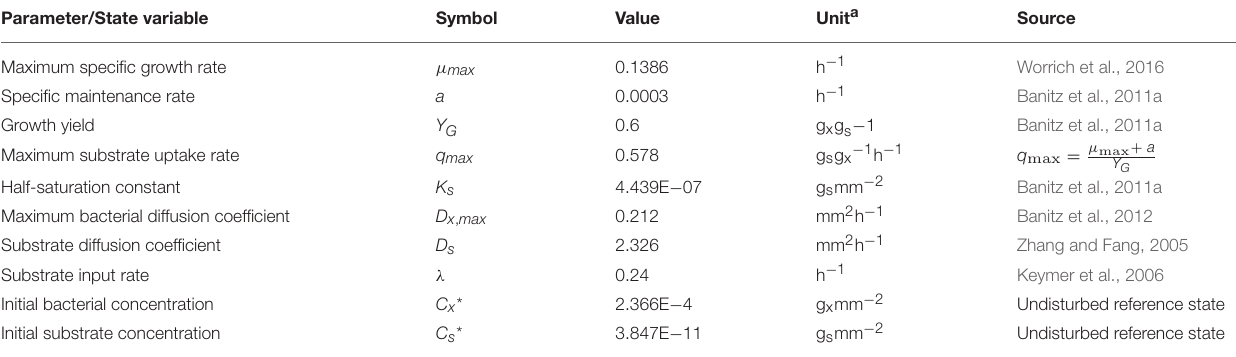
TABLE 1 | Base set of model parameter values and initial